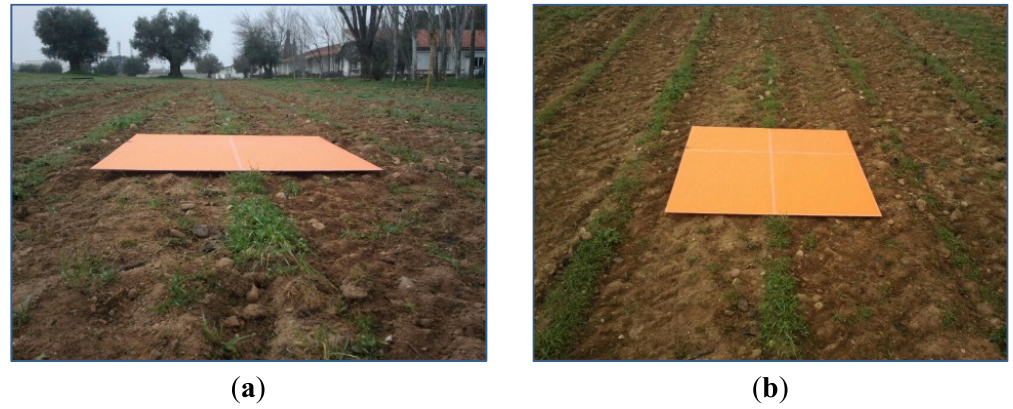
Figure 10. Images of the same ROI at a fixed distance and the same pitch angle: ( a ) with the camera almost at ground level; ( b ) image obtained at a greater height from the